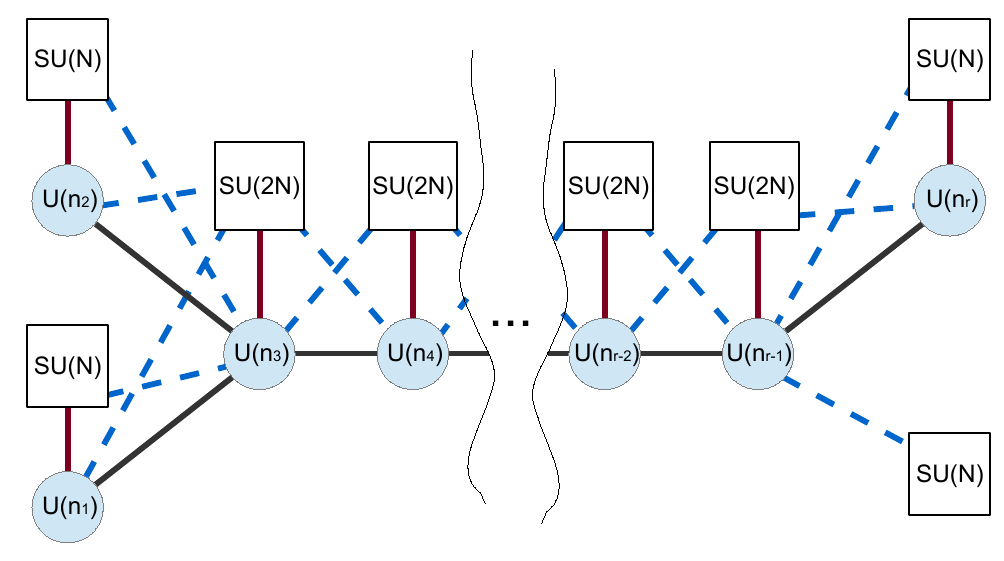
Figure 10 . Quiver gauge theory for the non-critical strings of N D5 branes probing a D r